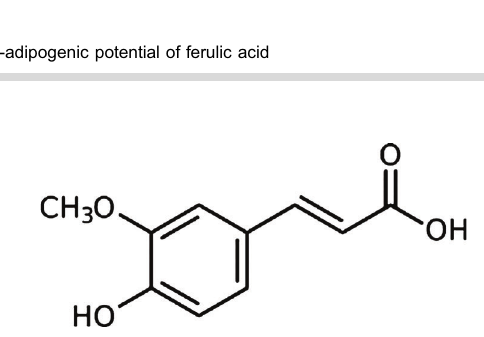
Figure 1. Chemical structure of ferulic acid ((E)-3-(4-hydroxy-3- methoxy-phenyl)prop-2-enoic